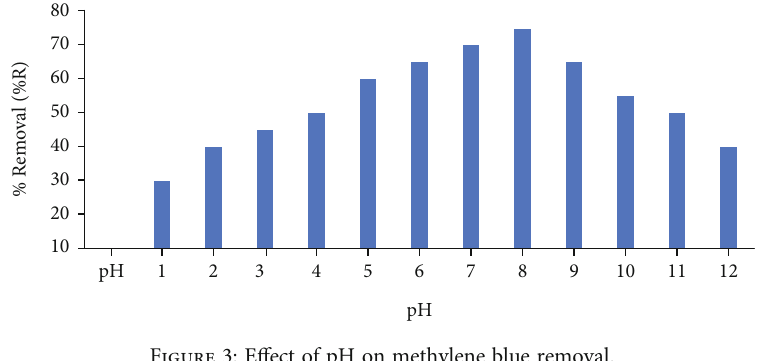
Figure 3: E ff ect of pH on methylene blue removal.